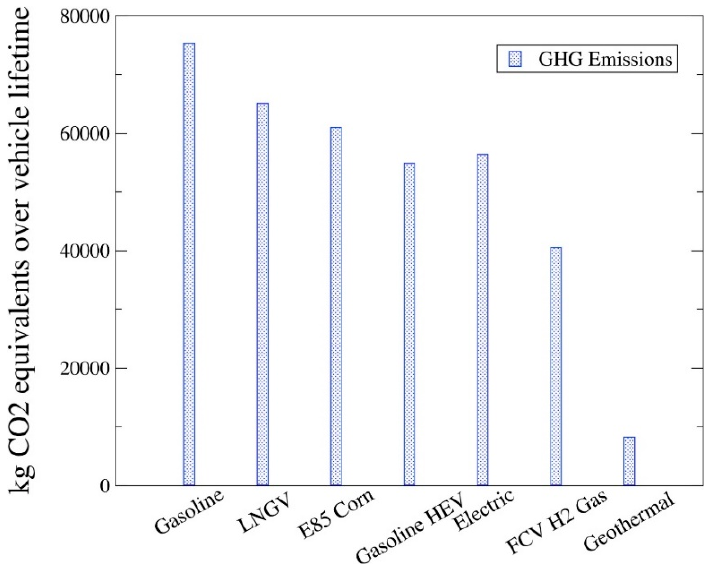
Figure 11. Comparison of GHG emissions for different vehicle types